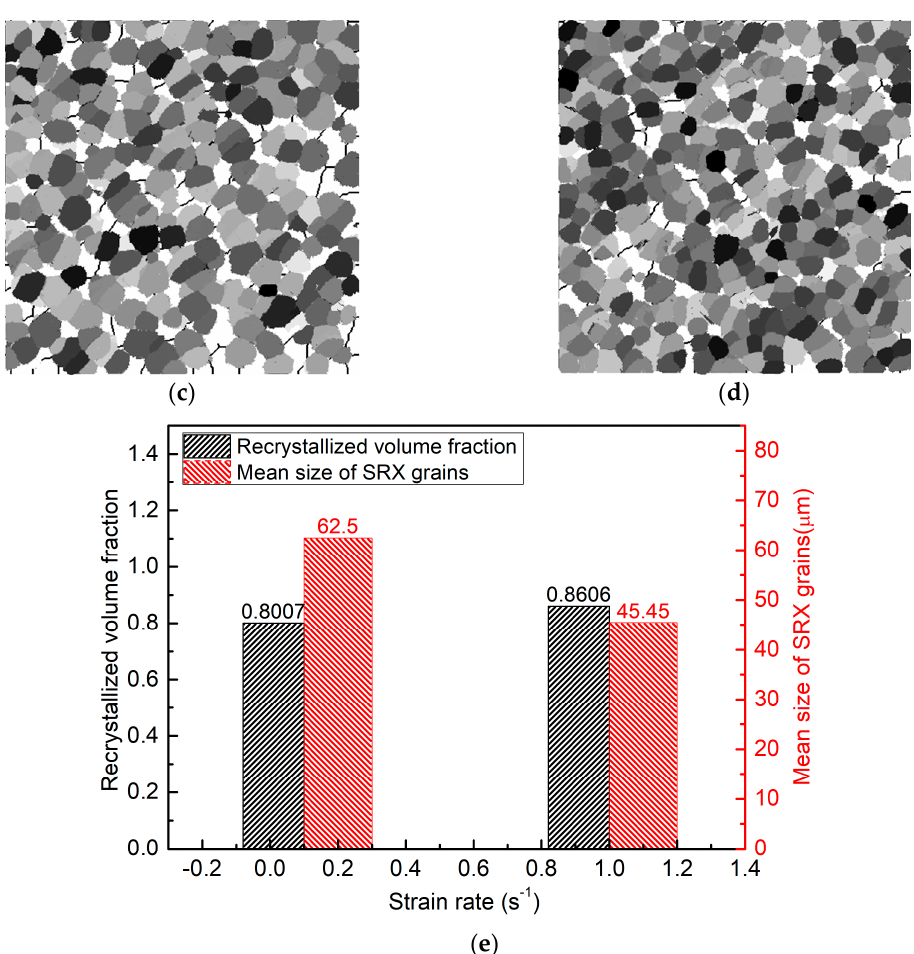
Figure 9. The experimental ( a , b ) and CA ( c , d ) results for microstructures formed at a strain rate of 0.1 s − 1 ( a , c ) and 1.0 s − 1 ( b , d ); ( e ) the variation of the recrystallized volume fraction and the mean grain size at strain rates of 0.1 and 1 s − 1 .